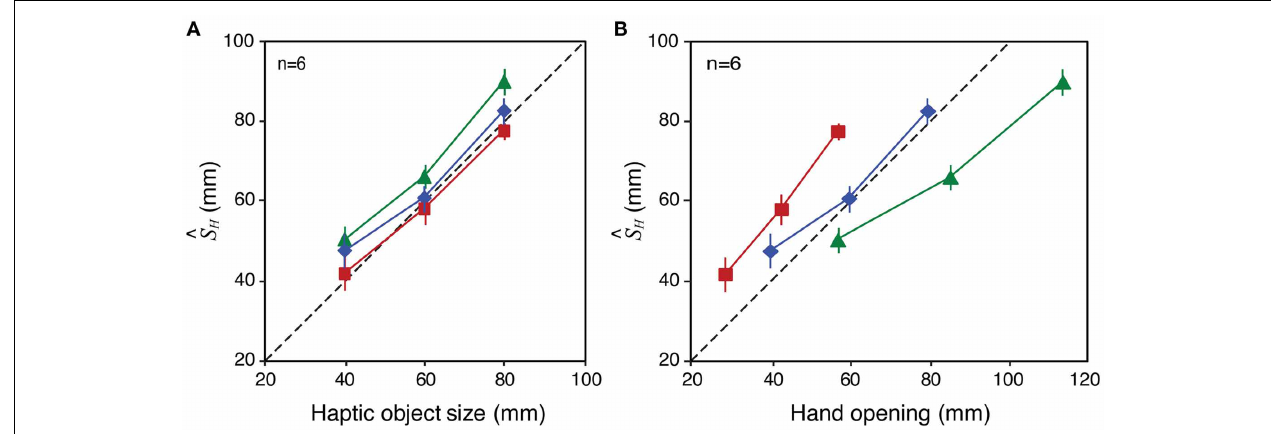
FIGURE 9 | Bias in haptic size estimates ( ˆ S H ) with different tool gains in Experiment 2. The figure shows ˆ S H in each condition as a function of haptic object size (A) and hand opening (B) . See main text for details of how these values were derived. Error bars denote ± 1 standard error in each